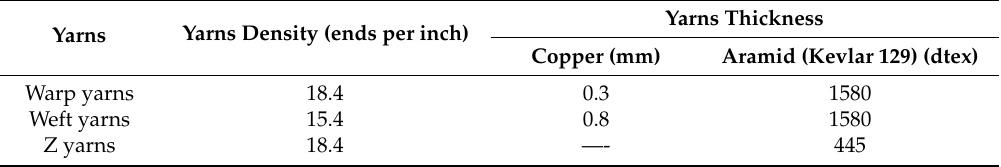
Table 2. The specifications of the yarns and weaving parameters for the three-dimensional woven fabric integrated